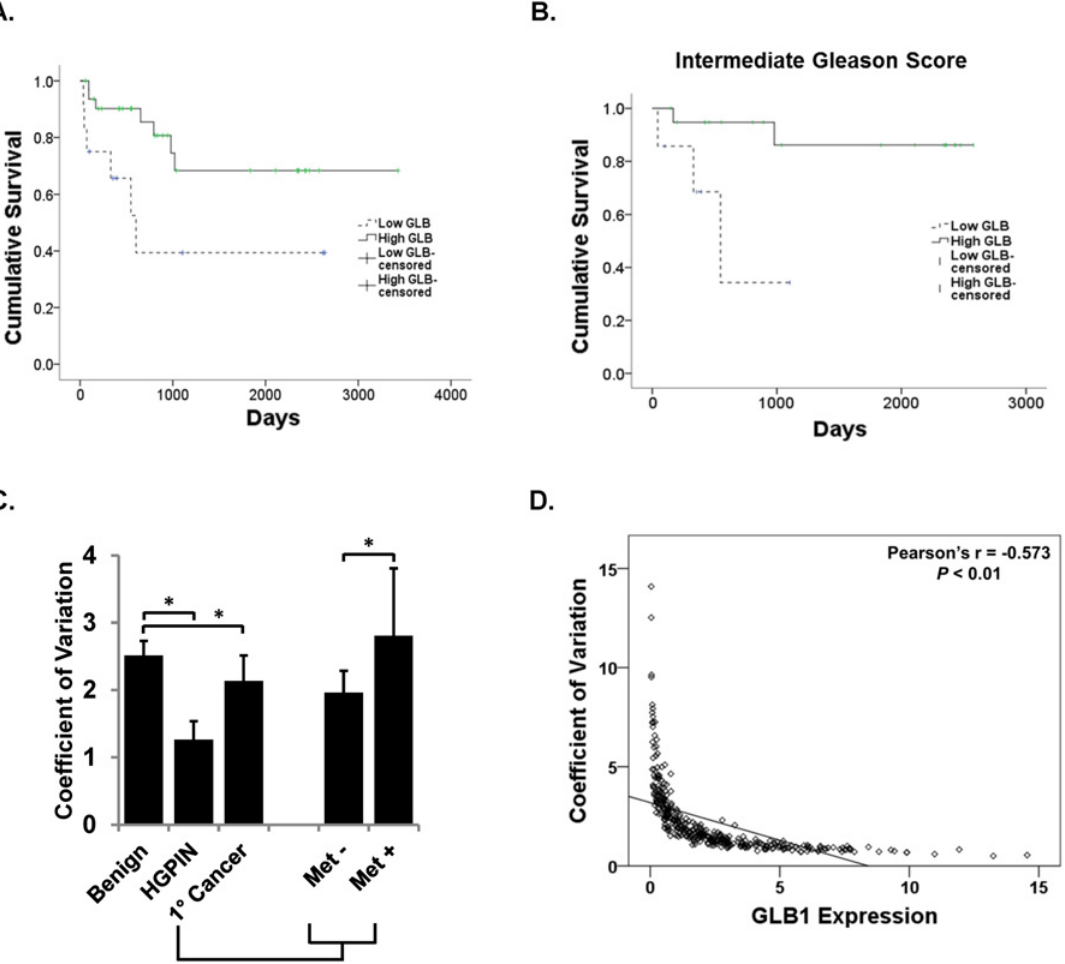
Fig 4. Increased GLB1 identifies patients at decreased risk of PCa recurrence. GLB1 expression on a per-core basis was measured using the Vectra platform in all tissues. Patients were stratified into high or low GLB1 levels based on median core expression. Kaplan-Meier survival curves are shown. (A) Increased GLB1 expression is associated with longer PSA-free recurrence in PCa patients. Stratified by low (n = 12) and high GLB1(n = 32) expression, cumulative PSA-free survival significantly increases in patients who had high GLB1 levels in a log rank analysis (p = 0.025). (B) High (n = 20) and low (n = 7) GLB1 levels predict PSA-free survival times (629 vs. 2314 days, respectively; p = 0.013) in intermediate Gleason Score (GS 6 – 7) patients. (C) . Per cell GLB1 expression is more homogenous in lower grade PCa tissues which express increased GLB1. GLB1 expression on a per-cell basis was then measured using the Vectra platform in all tissues. HGPIN had the least heterogeneity (p < 0.001). Primary cancer tissue overall has significantly less heterogeneity than benign (p < 0.001). Primary cancer cells with associated metastatic disease (Met+) had lower levels compared to localized tumors without the presence of metastatic (Met-) disease (p = 0.001) (D) . Mean nuclear GLB1 expression was inversely correlated with the coefficient of variation (representing heterogeneity) of the cores (Pearson's r = -0.573; p < 0.01; N = 265). Tissues that display the highest levels of GLB1 staining have the most homogenous